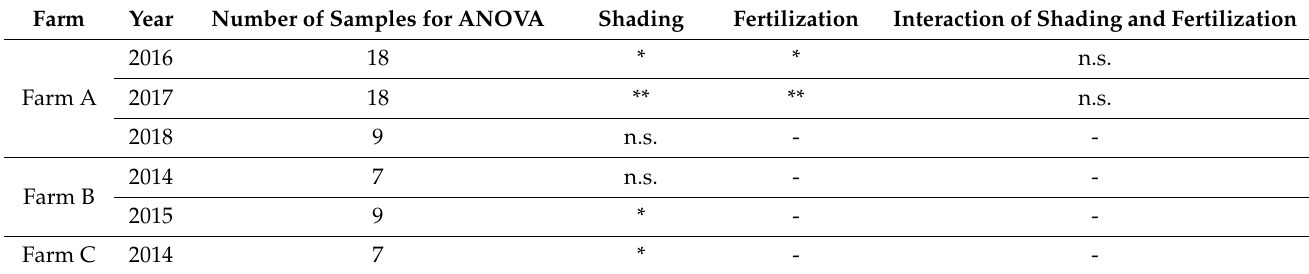
Figure 6. Relationship between average grain weight and shading rate. Table 4. Influence of shading and fertilization on grain weight.